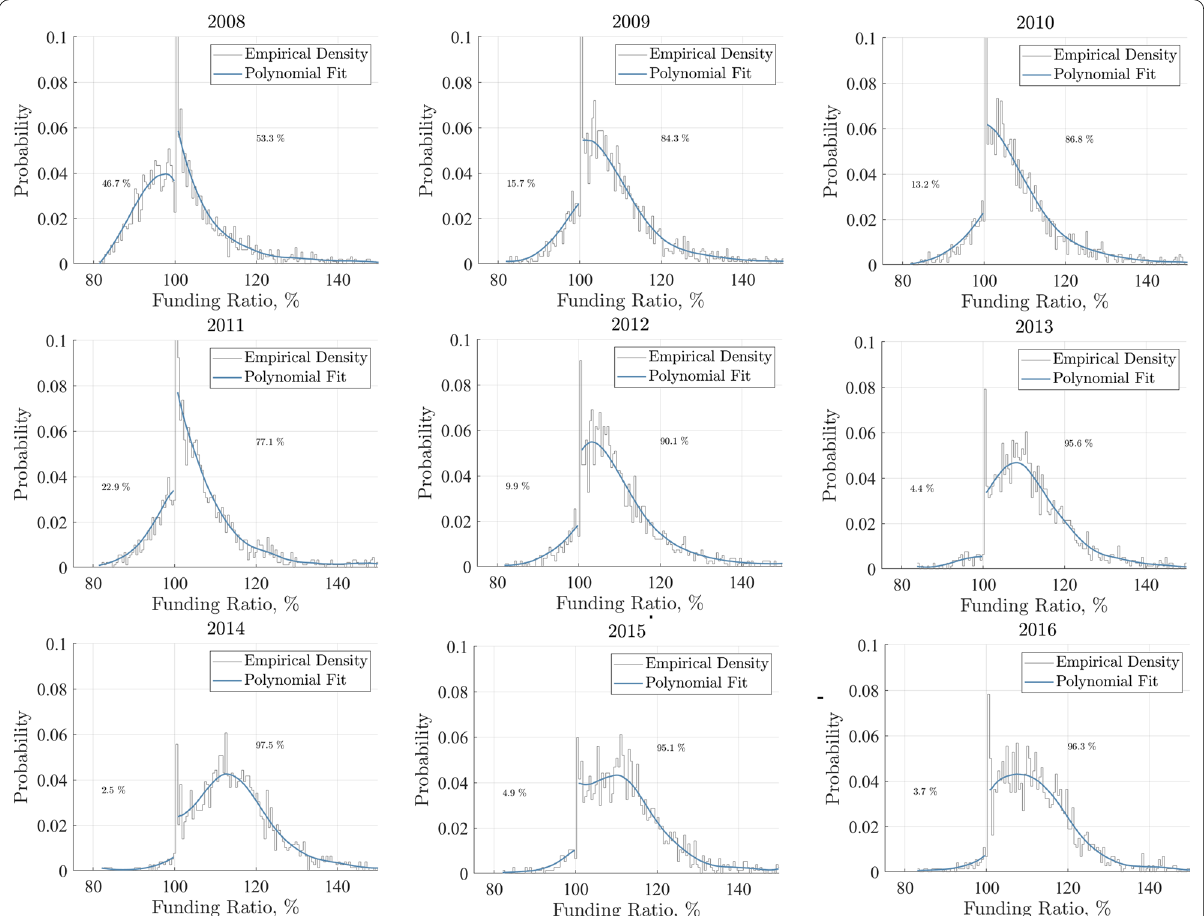
Fig. 9 Distribution of Funding Ratios. Annual distributions of the funding ratios of pension funds, 2008–2016 (years 2007 and 2017 in the main text). Figure at bottom right shows pooled distribution including all pension fund observations for all years. The solid line shows the smoothed fit using a local 4th order polynomial kernel regression to the left and to the right of 100%. Binwidth of histogram and bandwidth of triangular kernel are based on the procedure by McCrary (2008). Bin at 100% omitted for polynomial fit. Figure shows spike exactly at the regulatory minimum (100%). The corresponding McCrary test for discontinuity between left and right of 100% (omitting the 100% bin) is positive and significant. The sample includes only private and public funds without state guarantees, and only includes funds with a funding ratio between 81.5 and 152.3% (0.5th–95th percentile